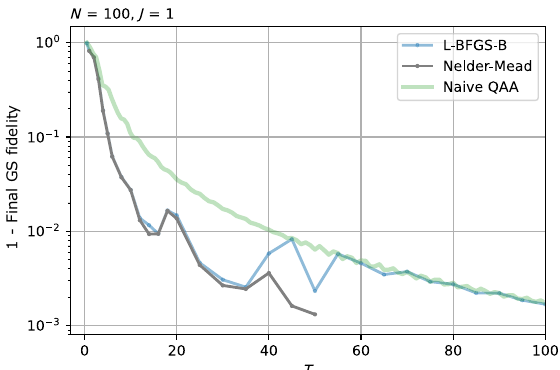
FIG. 11. The large- T black-box optimizer benchmark for the two classical optimization algorithms L-BFGS-B and Nelder- Mead (NM). The data for NM are only obtained up to T = 50 and require, in general, more measurements than gradient-based methods. However, the optimization with L-BFGS-B becomes increasingly unstable for large T > 40 and NM is observed to be more robust, because a very large amount of fine tuning of the initial step size is required for the different values of T .